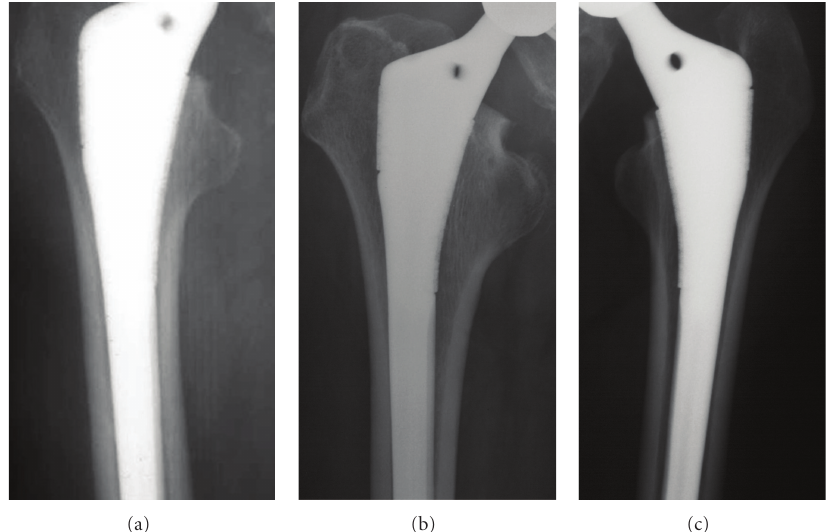
Figure 2: The metaphyseal fit evaluation in AP radiographs. (a) The medial side of the stem was in contact with the endosteum of the medial femoral cortex through the area of proximal fiber-mesh coating. The metaphyseal fit was defined as good. (b) The medial side of the stem was not in contact with the endosteum of the medial femoral cortex at any area of proximal fiber-mesh coating. The metaphyseal fit was defined as poor. (c) The medial side of the stem was not in contact with the endosteum of the medial femoral cortex at the distal area of proximal fiber-mesh coating. The metaphyseal fit was defined as poor.